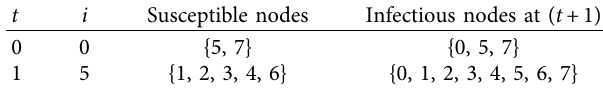
Table 7: Spread period example with